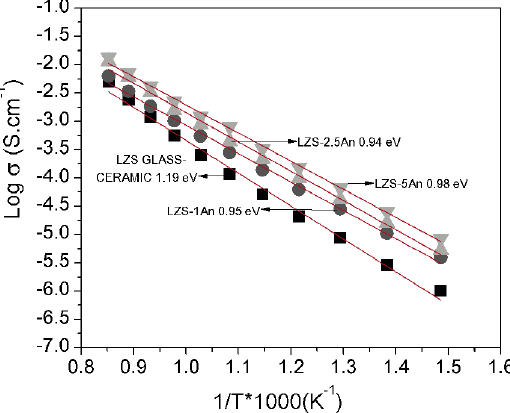
Figure 4. Arrhenius plot (Log conductivity versus the inverse of temperature) for samples of the LZS glass-ceramic (without Al and for the composites containing 1, 2.5 and 5 vol.% of nanosized Al O sintered by fast firing at 900 ºC for 30 min. 2 3